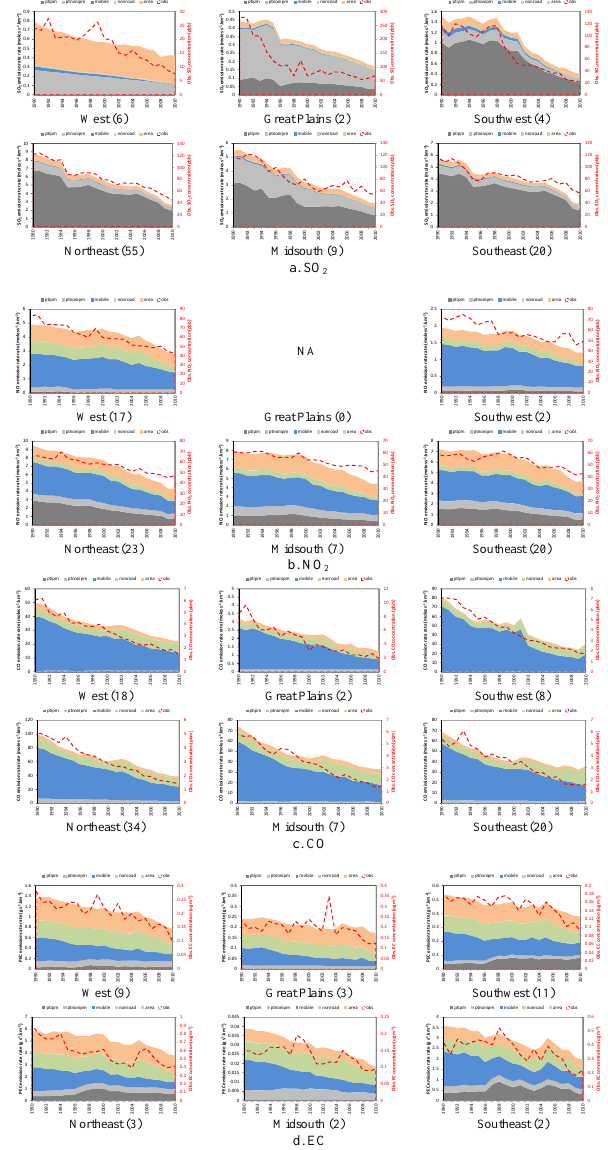
Fig. 12. Comparison of historic trends between emissions and ob- Fig. 12 Comparison of historic trends between emissions and observed concentration from 1990 served concentration from 1990 to 2010 by sector and region (num- to 2010 by sector and region (number of sites are shown in brackets) ber of sites are shown in